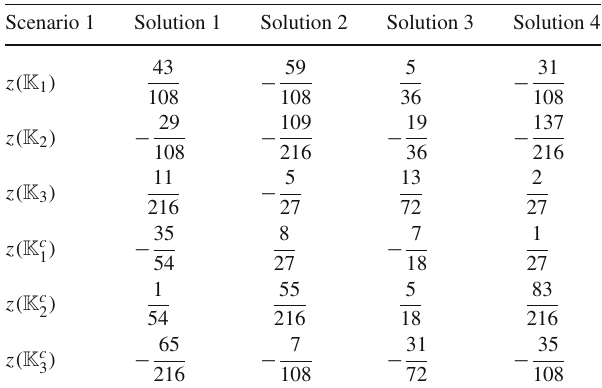
Table 20 The same as in Table 17, but with the minimal number of singletsundertheSMgaugegroup n ν c = 1 , n S = 1 , n N = 1 and n ξ = 2